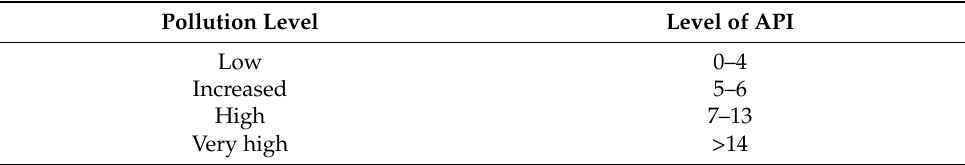
Table 2. Estimation of the air pollution levels by Air Pollution Index (API). Pollution Level Level of